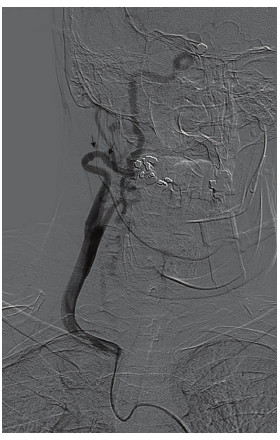
Figure 3: The picture was taken on the second day of hospitaliza- tion: hematoma had spread to the upper chest reaching the right